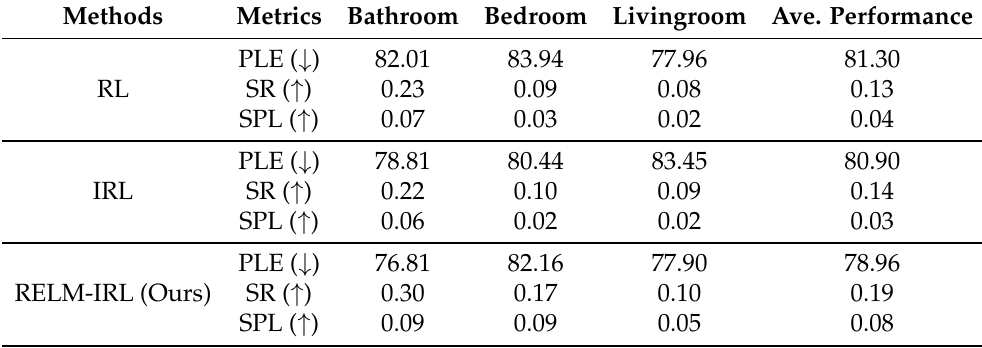
Table 3. Quantitative results on similar targets for the new scenes in Task (III). The best results in individual scenes and the best average results across all scenes are shown in blue and red,